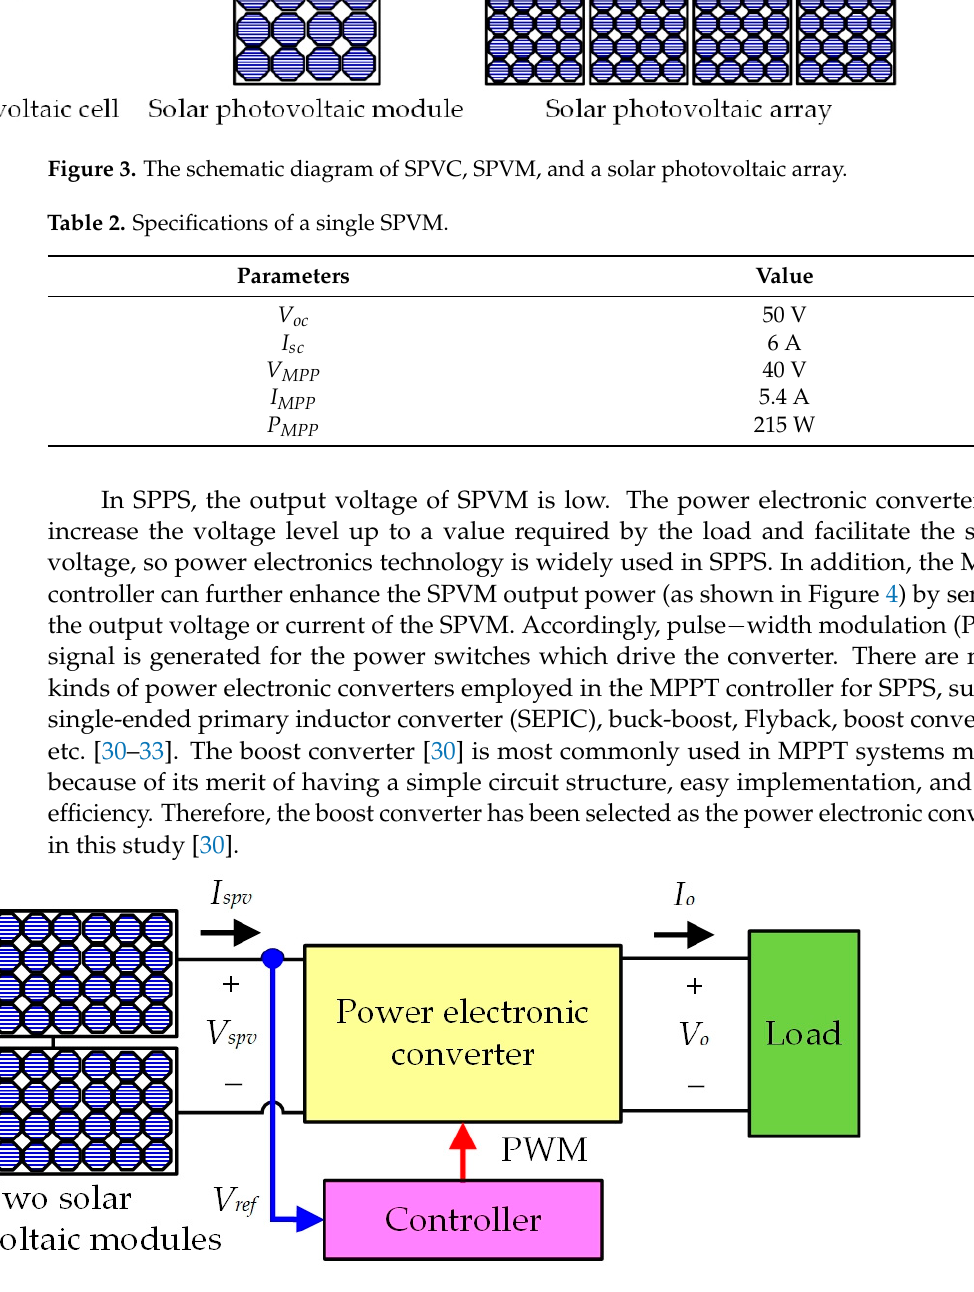
Figure 4. The schematic diagram of two SPVMs connected with a power electronic converter.